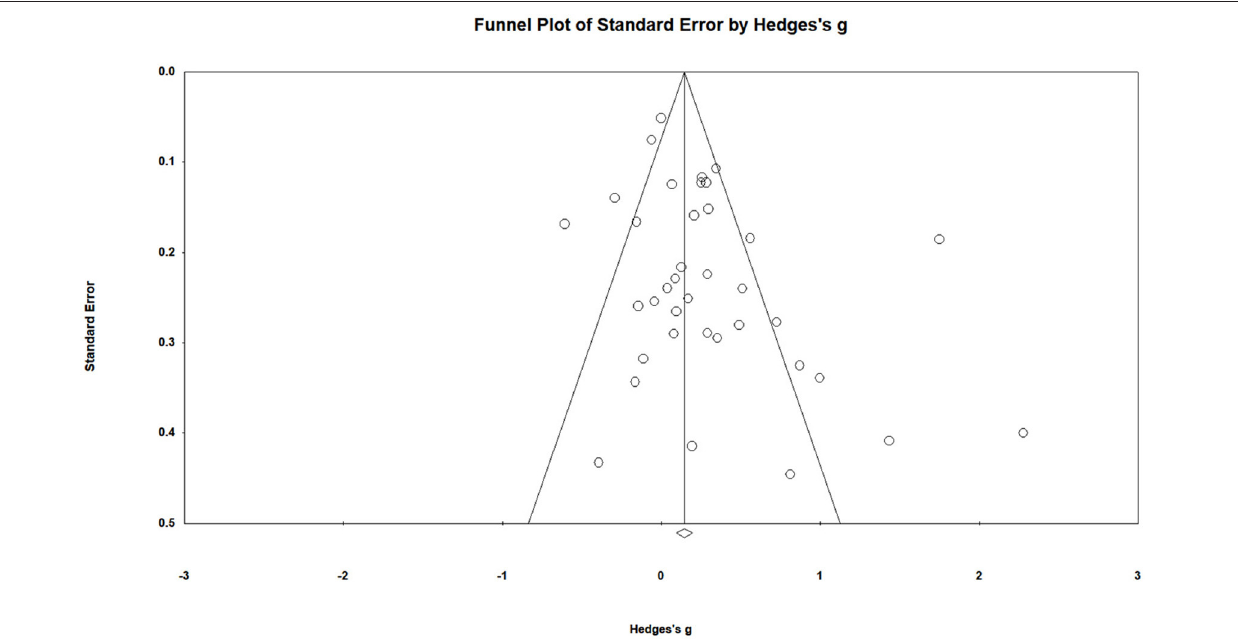
FIGURE 2 | Funnel plot of positive affective variables in this